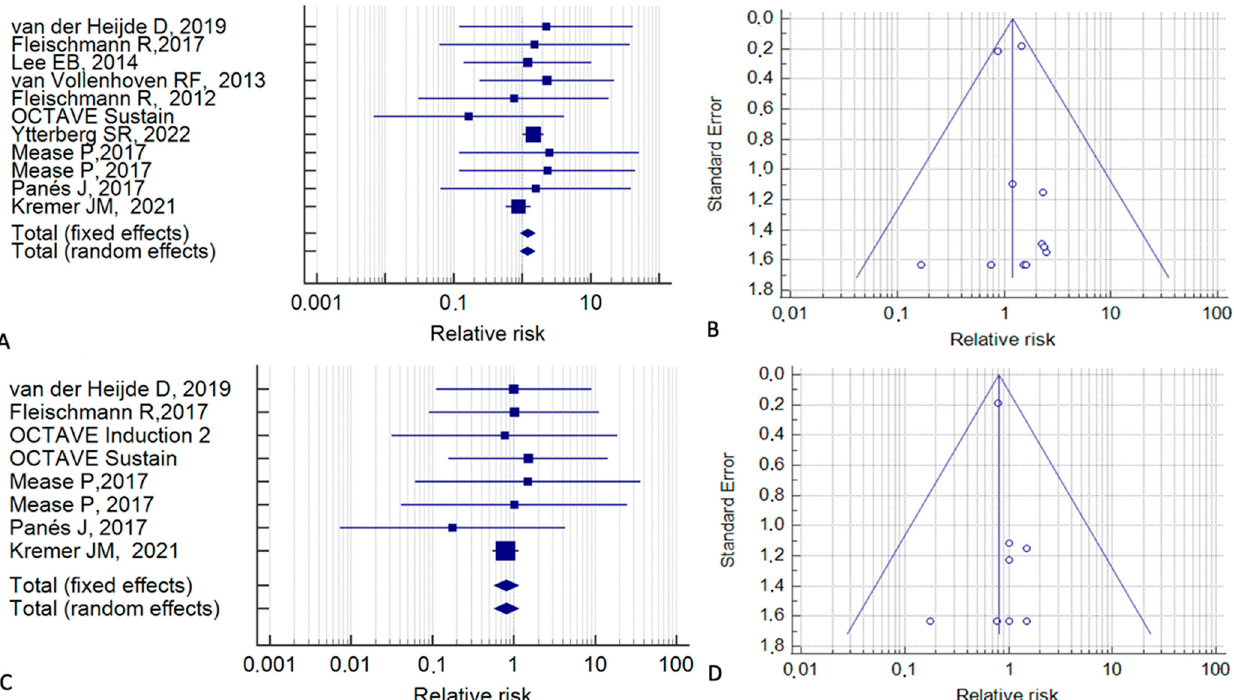
Figure 3. Risk of malignancy, treating non-melanoma skin cancer separately, in tofacitinib-treated patients vs. control patients who received a placebo or an active treatment. ( A , B ) Malignancy excluding non ‐ melanoma skin cancer. ( C , D ) Non ‐ melanoma skin cancer alone [2,15,20–22,24,25,35,36,39].